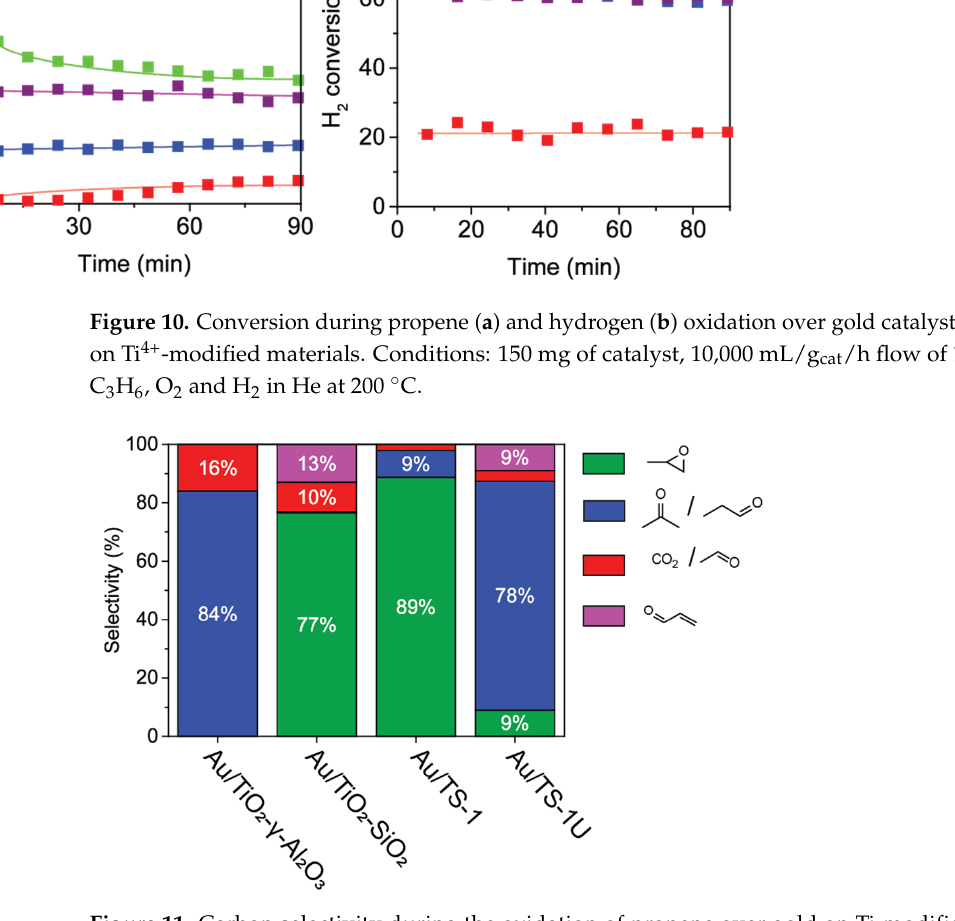
Figure 11. Carbon selectivity during the oxidation of propene over gold on Ti-modified supports. Conditions: 150 mg of catalyst, 10,000 mL/g cat /h flow of 10% of each C 3 H 6 , O 2 and H 2 in He at 200 °C.